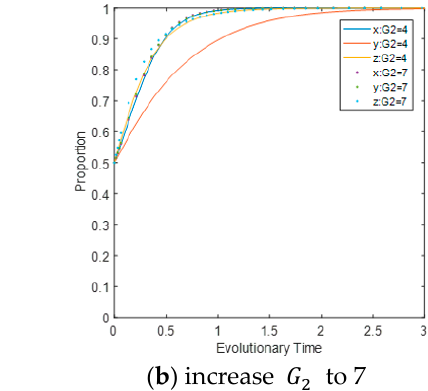
Figure 4. Impact of G 2 on the evolutionary path of multi-agents.